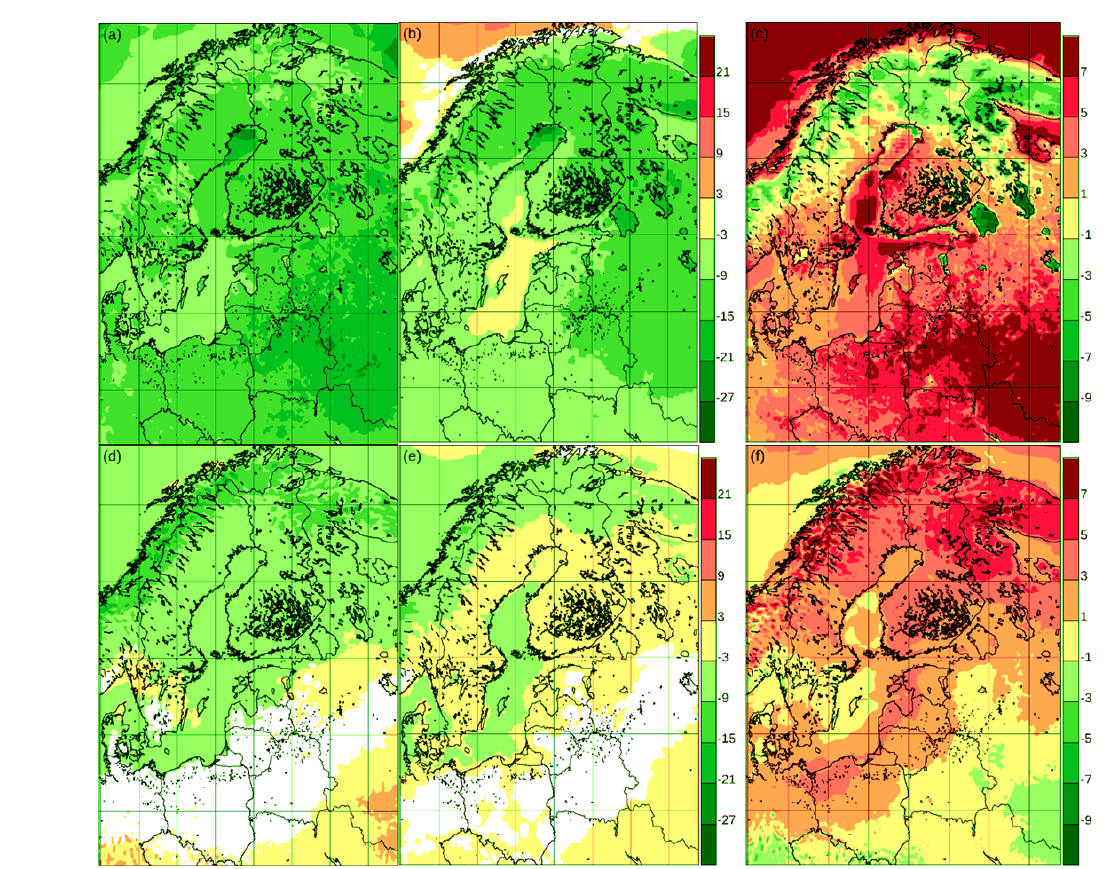
Figure 13. Average incoming solar radiation relative change (%) between 1981–2010 and 2071–2100 for five atmosphere-only RCA4 simulations from EURO-CORDEX according to the RCP8.5 scenario (a, d) and for the coupled single-model RCA4-NEMO ensemble with the same driving GCMs (c, f) ; pointwise median values, only coloured when 75% of simulations agree on the sign of the change. Difference between the two ( c , f ; coupled minus uncoupled; %). (a–c) Winter; (d–f)